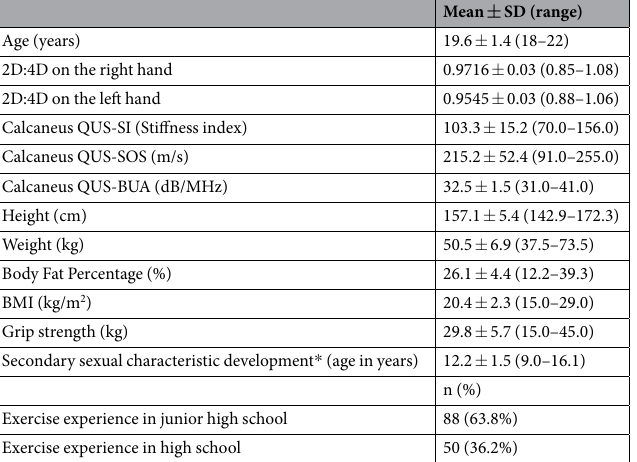
Table 1. Subject characteristics, n = 138. 2D:4D, ratio of the finger length of the 2 nd and 4 th digit; BMI, body mass index; QUS-SI, stiffness index by quantitative ultrasound; QUS-SOS, speed of sound by quantitative ultrasound; QUS-BUA, broadband ultrasound attenuation by quantitative ultrasound. * The age at which menstruation